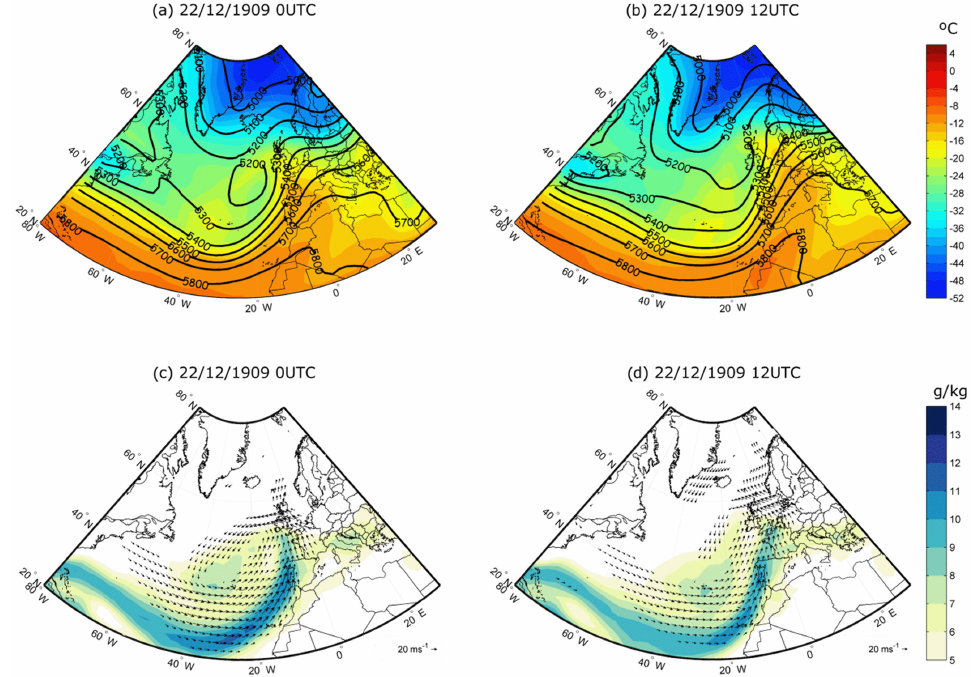
Figure 15. The geopotential height (contour, m) and air temperature (shaded; ◦ C) at 500hPa level for 22 December: (a) 00:00UTC and (b) 12:00UTC. The wind vector (ms − 1 ) and specific humidity (shaded, gkg − 1 ) at 900hPa level for the 22 December 1909 at (c) 00:00UTC and (d) 12:00UTC are also shown. Only wind vectors with wind speeds above 12.5ms − 1 are